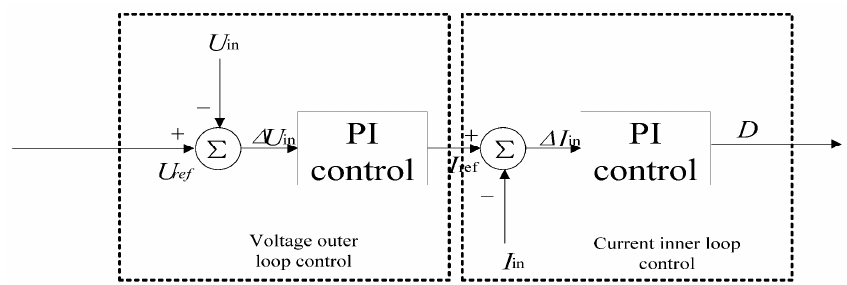
Figure 9. Boost chopper double closed-loop control system structure.